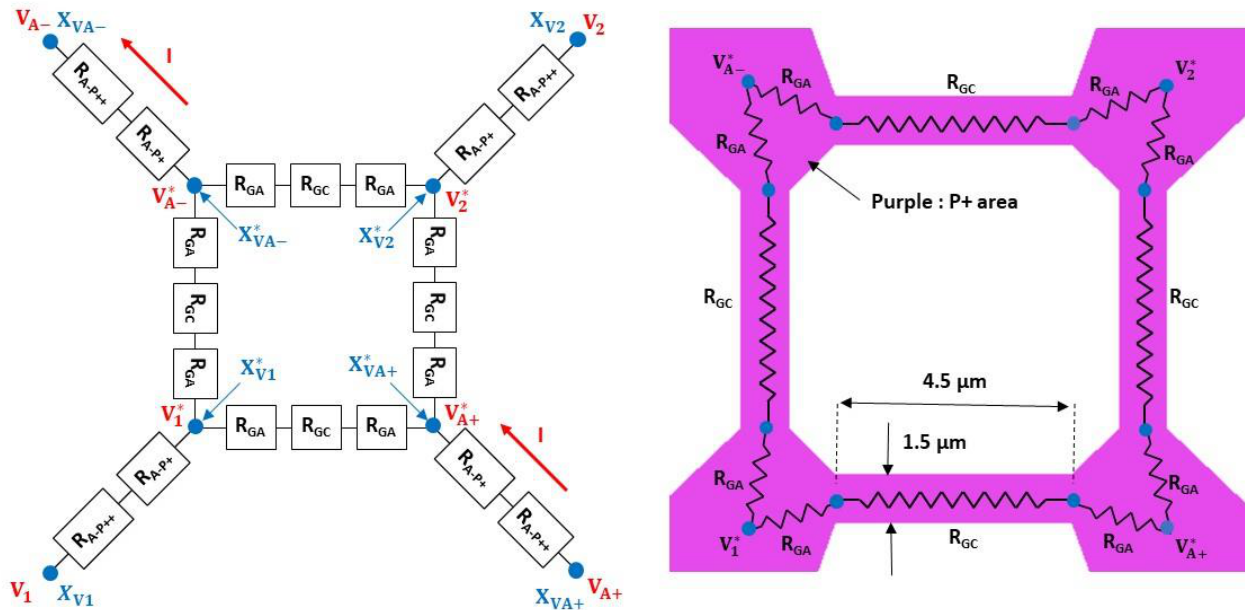
Figure 13. Electrical model of the pressure sensor.